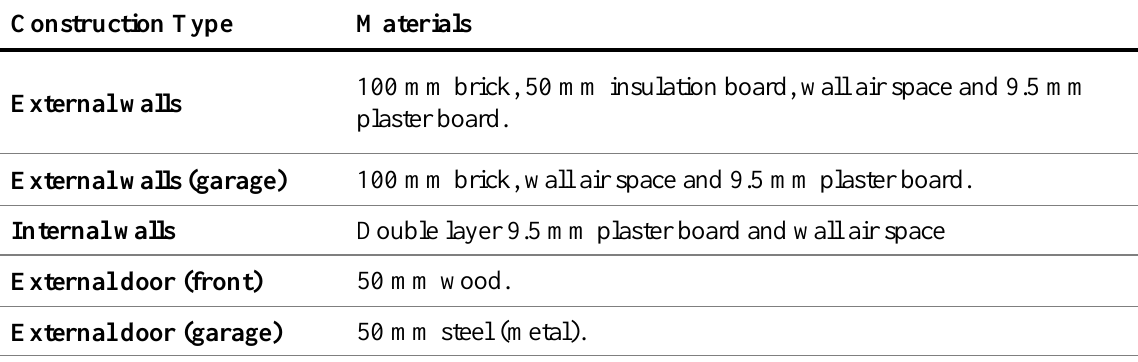
Table 3. Construction specifications of the zero-energy house model